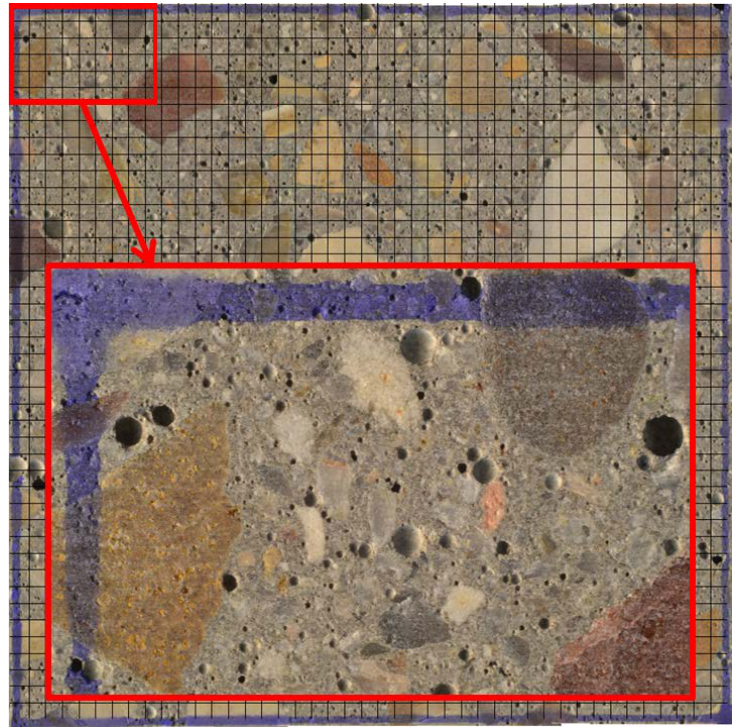
Figure 4. Grid superimposed on the final assembled image of 8.5 cm × 8.5 cm of the area of analysis.